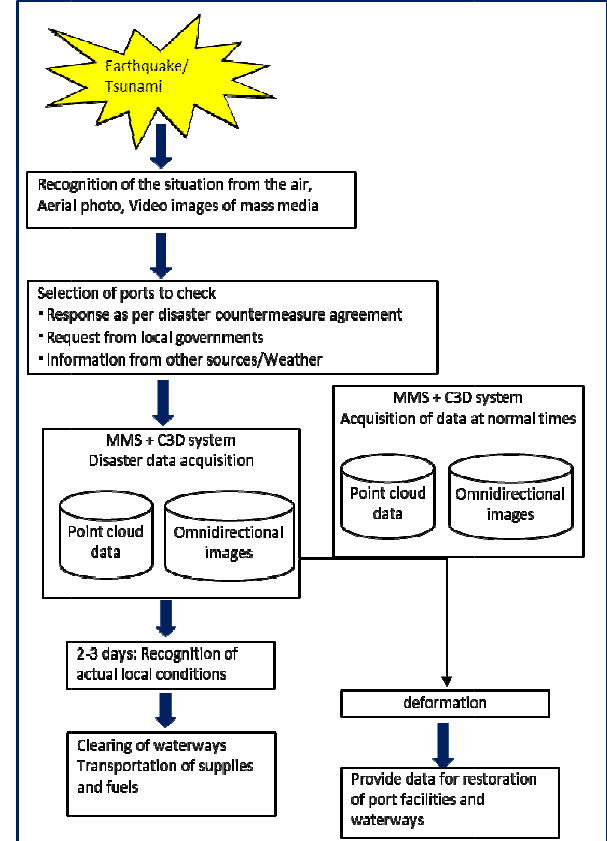
cadastre of Japan Coast Guard and tsunami hazard